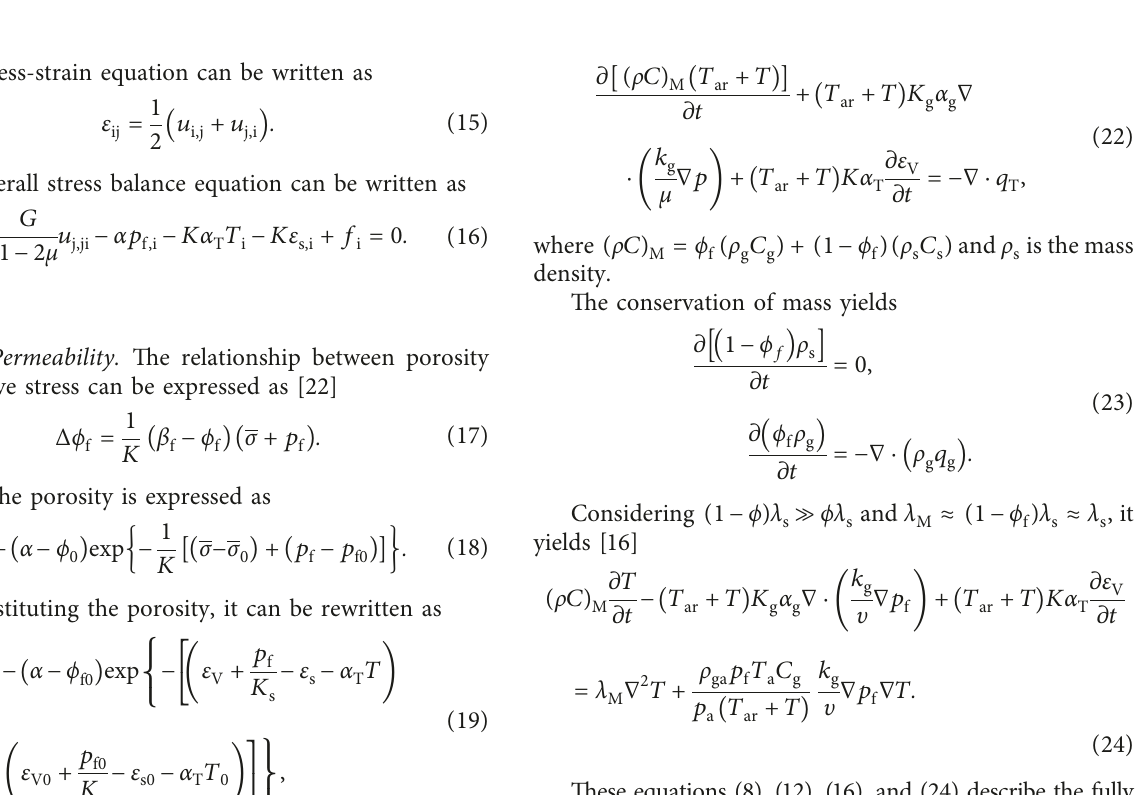
Figure 1: A conceptual model for gas storage and transport in the coal seams. (a) Natural fracture networks. (b) Stage 1: desorption from internal surfaces. (c) Stage 2: flow/diffusion in the matrix. (d) Stage 3: flow in the natural fracture